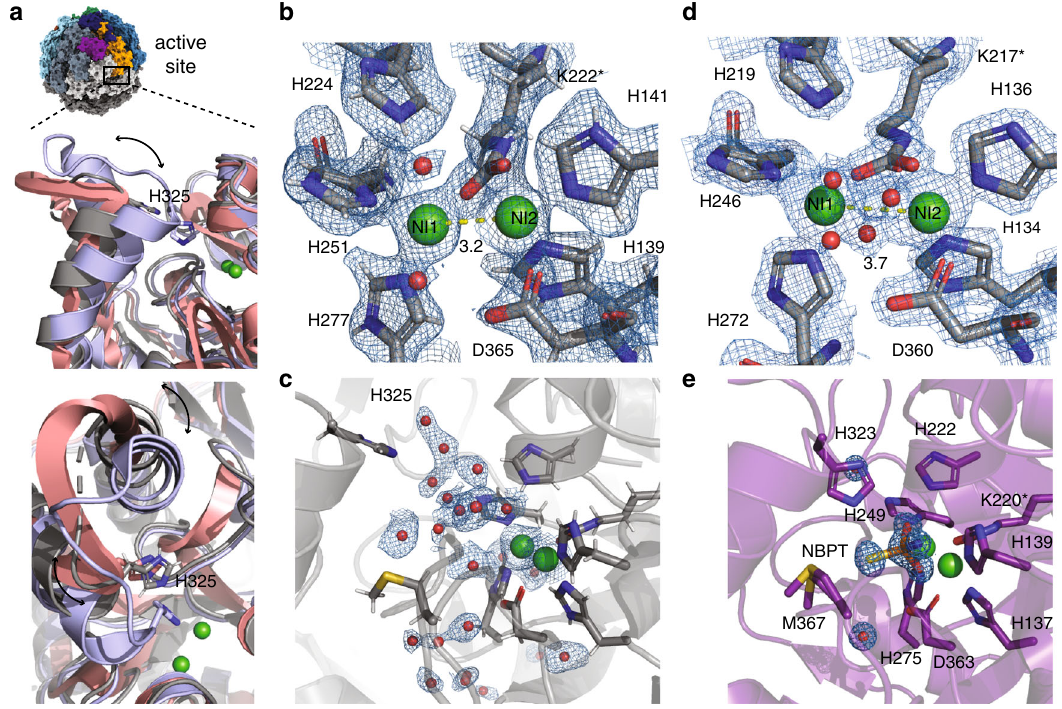
Fig. 5 Active site of Y. enterocolitica urease. a Overview of urease assembly with the active site location indicated. Inset shows in top panel side view of urease crystal structures from S. pasteurii mobile fl ap shown in open conformation in salmon (PDB: 2UBP) and in closed position as light purple (PDB: 3UBP). In gray the cryo-EM structure of Y. enterocolitica is overlaid and the green spheres represent the Ni 2 + ions of the active site. Bottom panel shows top view of the three structures. Arrows indicate movement of helix and catalytic His325 is shown as stick. b Model of active site residues and Ni 2 + ions with the cryo-EM map of Y. enterocolitica at 1.98 Å nominal resolution. Yellow line indicates distance between Ni 2 + ions in Å; c shows the water molecules in the active site. d Crystal structure of K. aerogenes urease at 1.9 Å resolution (PDB: 1EJW). Yellow line indicates distance between Ni 2 + ions in Å. e Crystal structure of S. pasteurii at 1.28 Å with inhibitor NBPT (PDB: